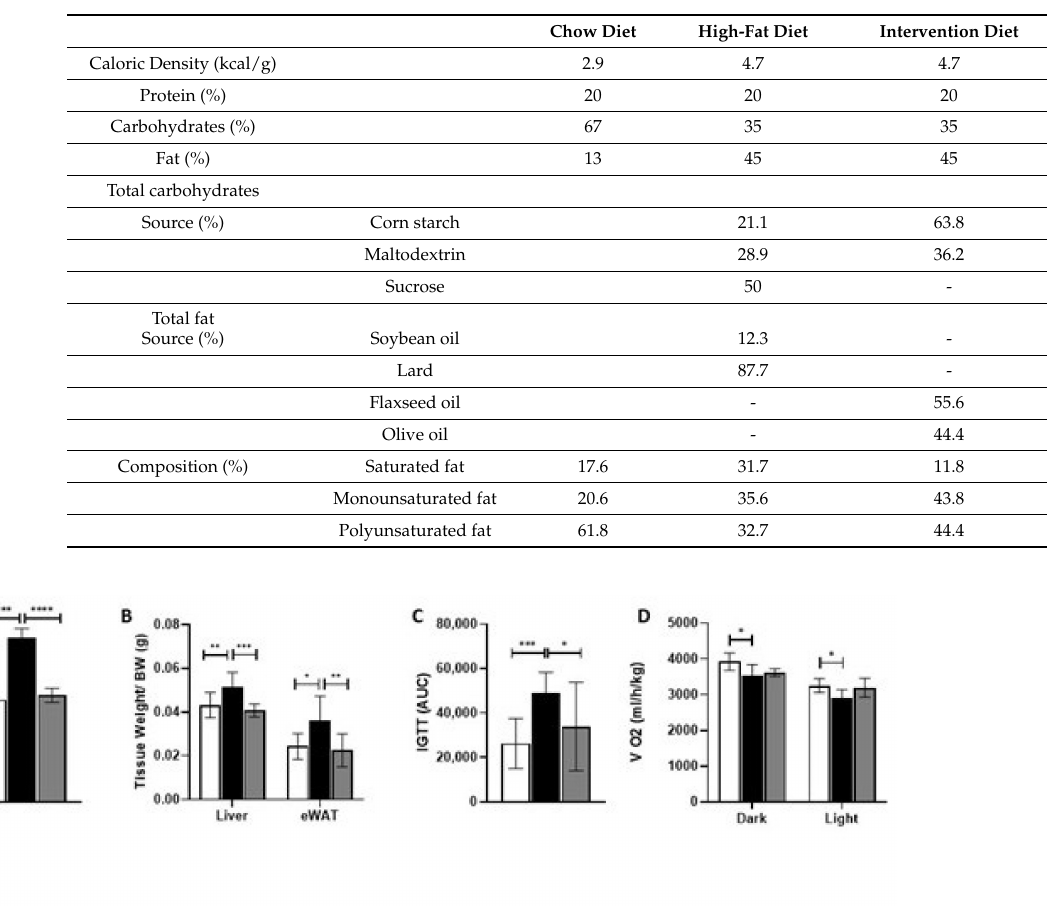
Table 1. Nutritional composition of the different diets used. Comparison in the energy content, macronutrients source and distribution of the 3 different diets.